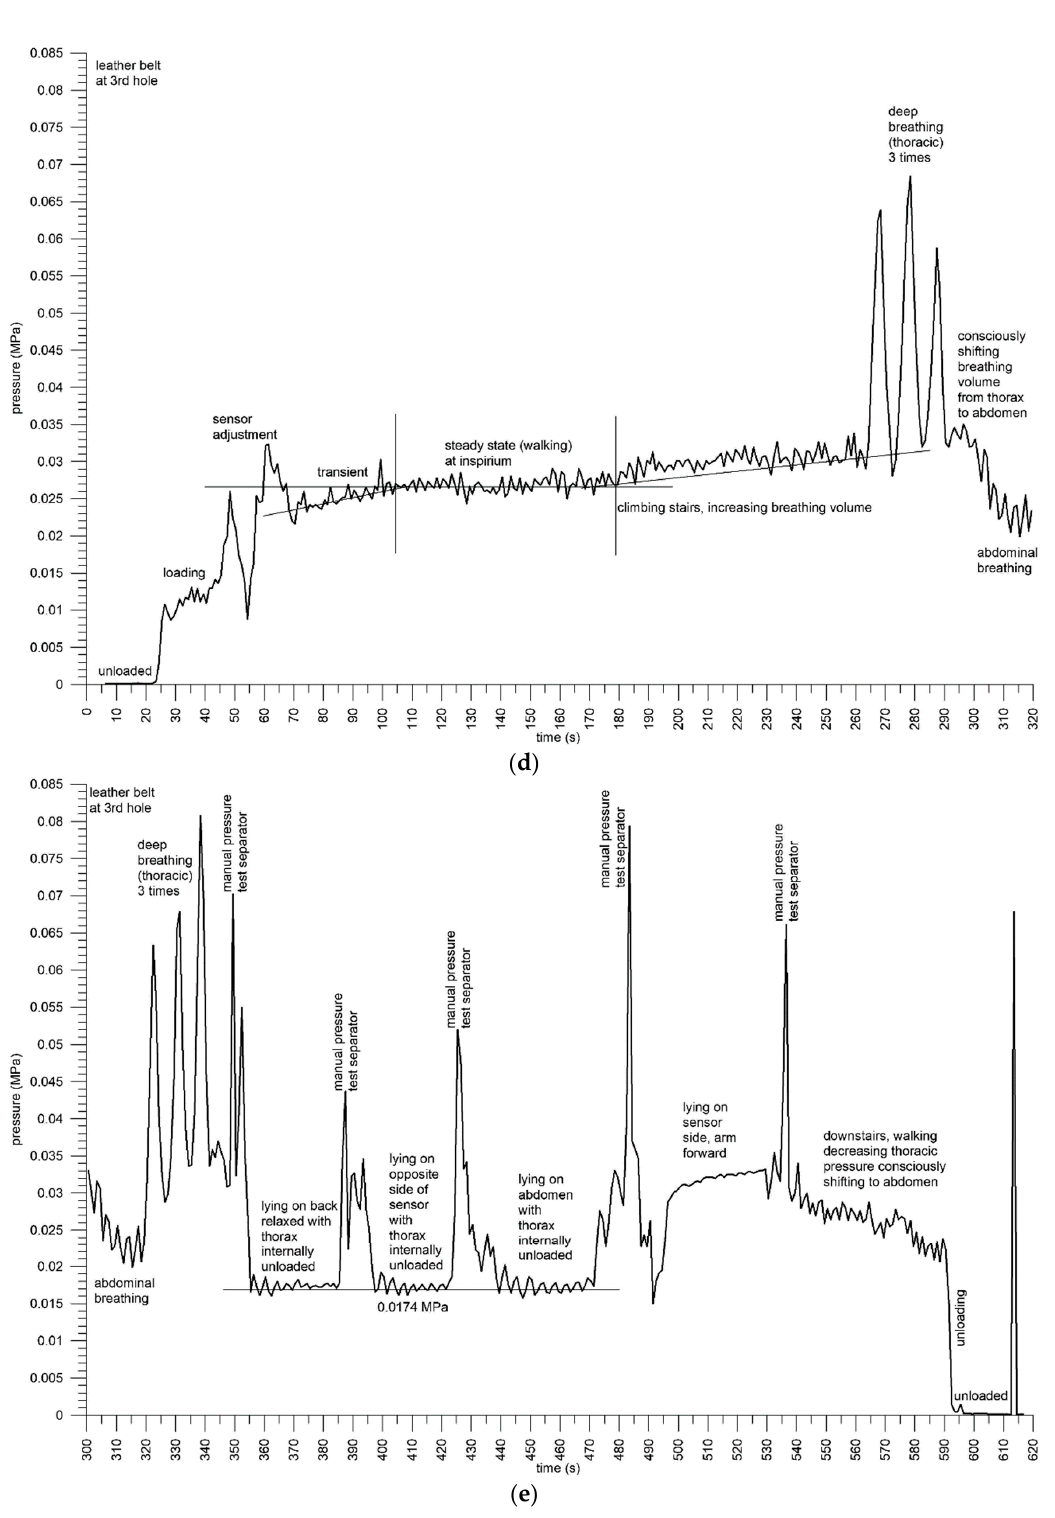
Figure 6. Pressure against time for Test 1 ( a ), Test 2 ( b ), Test 3 ( c ) and Test 4, first ( d ) and second ( e ) halves, respectively.